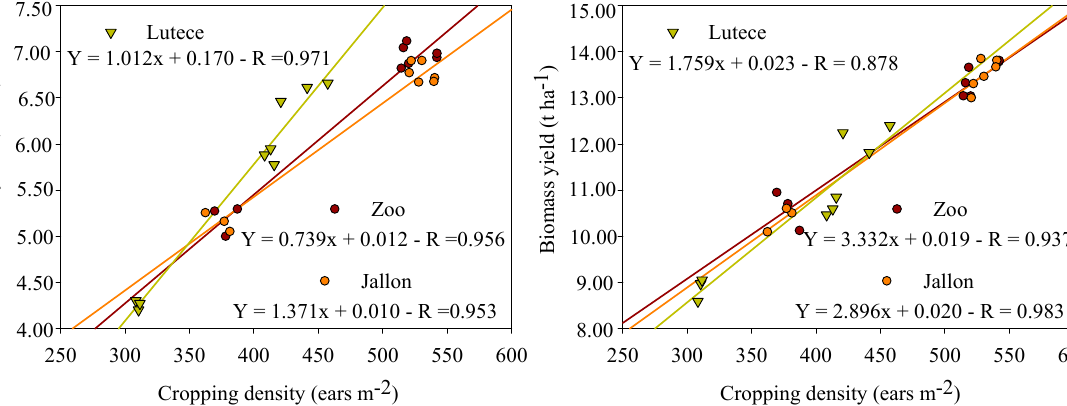
Figure 1. Relation between crop density, grain yield, and biomass yield for the conventional barley variety (Lutece) and for the barley hybrids (Zoo and Jallon).